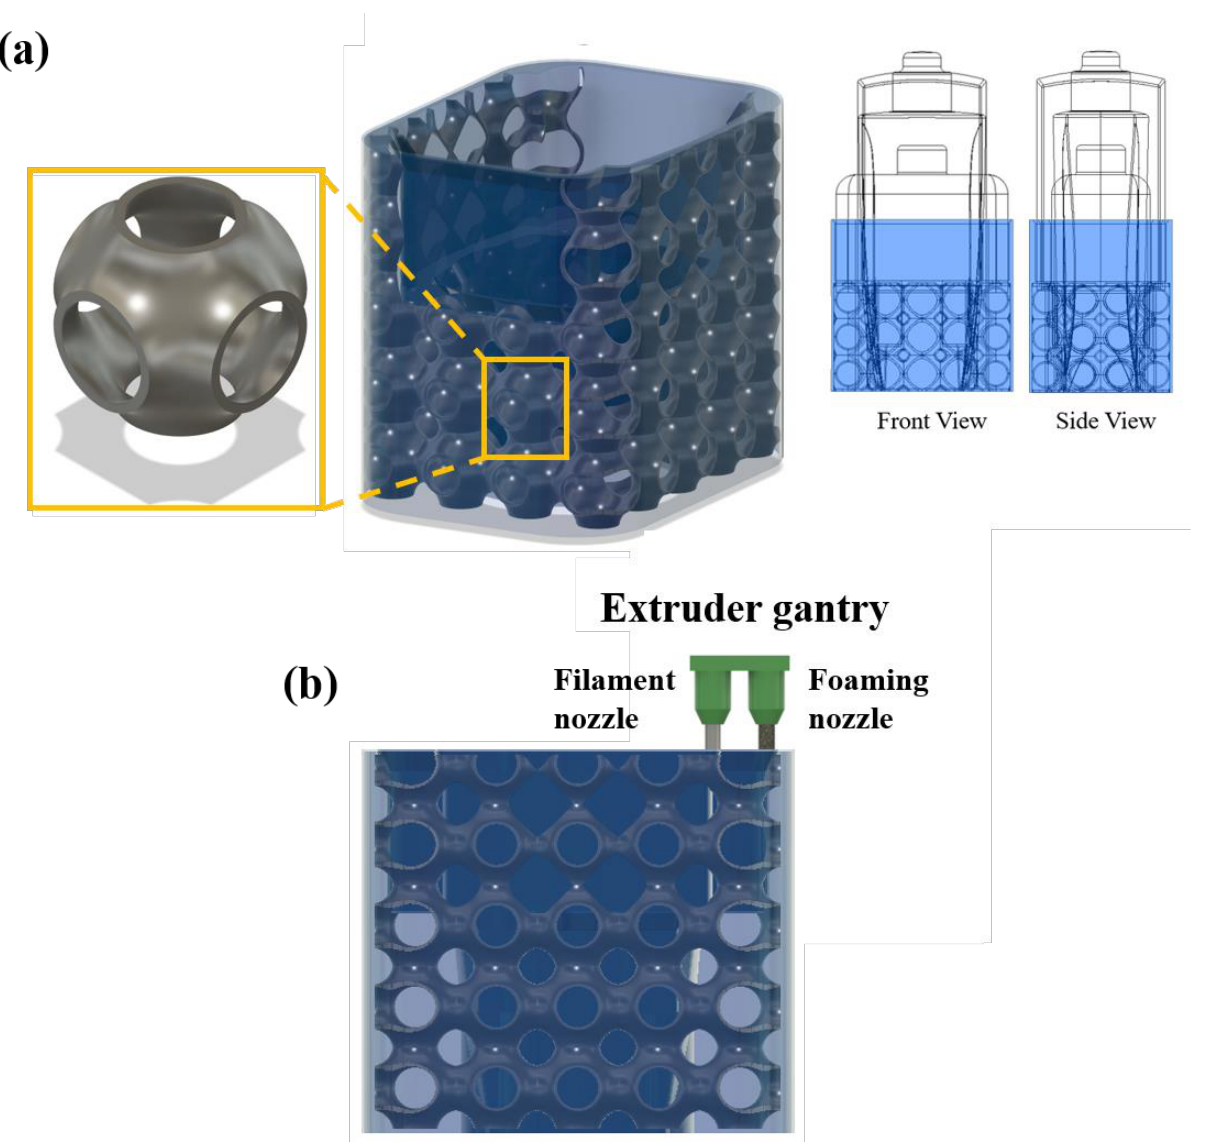
Figure 9. ( a ) Universal puck design with supportless SU lattice infill ( b ) Foam filling in the second puck using the second FDM nozzle.